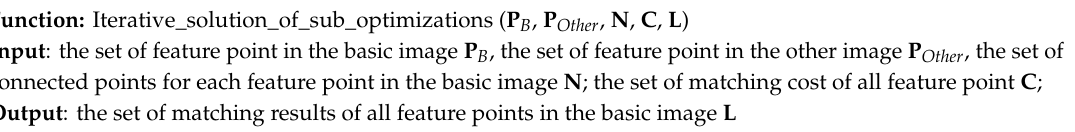
Algorithm 1: The iterative solution of the sub-optimization in the proposed